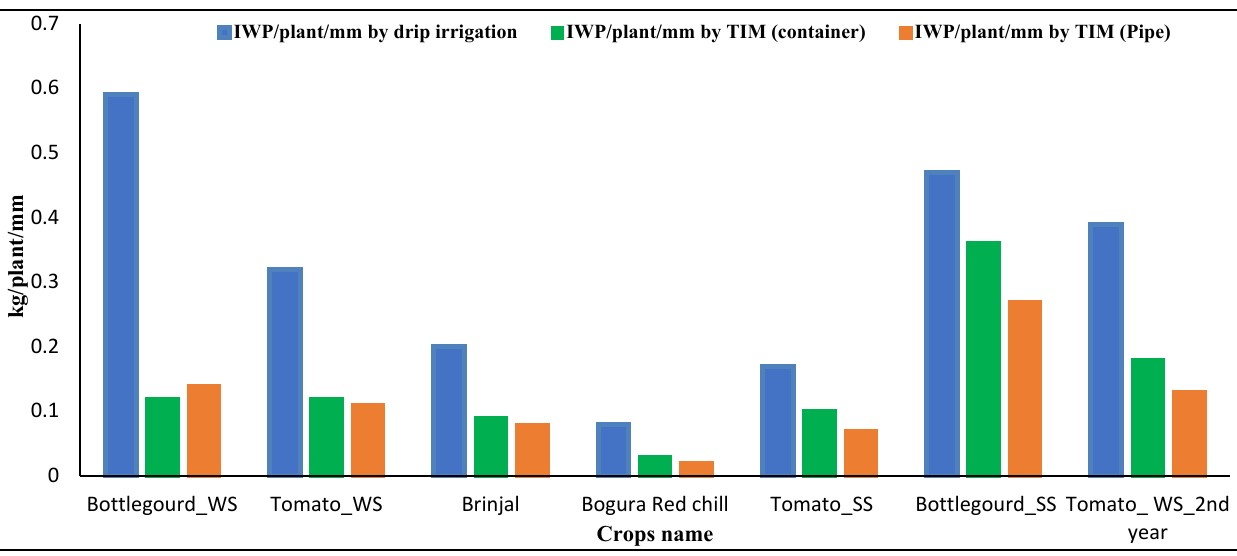
Figure 10. Irrigation water productivity of selected crops in URTA with drip irrigation and traditional irrigation (container and pipe) method.